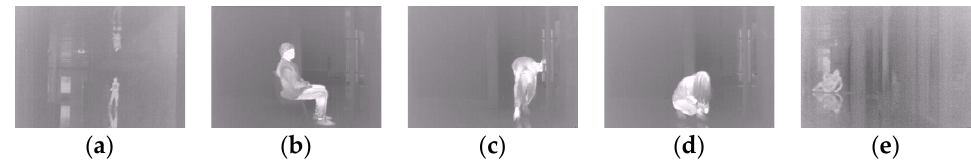
Figure 9. Self-collected dataset of thermal imaging abnormal behavior in indoor scenes. ( a ) walk ( b ) sit down ( c ) bend over ( d ) crouch down ( e ) fall down.